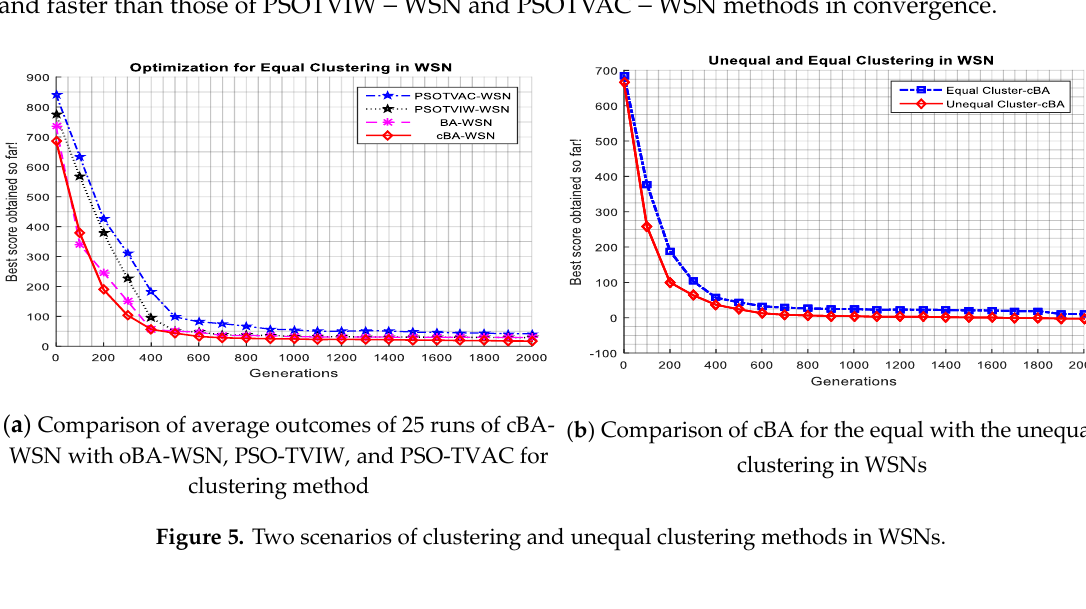
Figure 5a indicates four curves of the cBA − WSN, oBA − WSN, PSOTVIW − WSN and PSOTVAC −